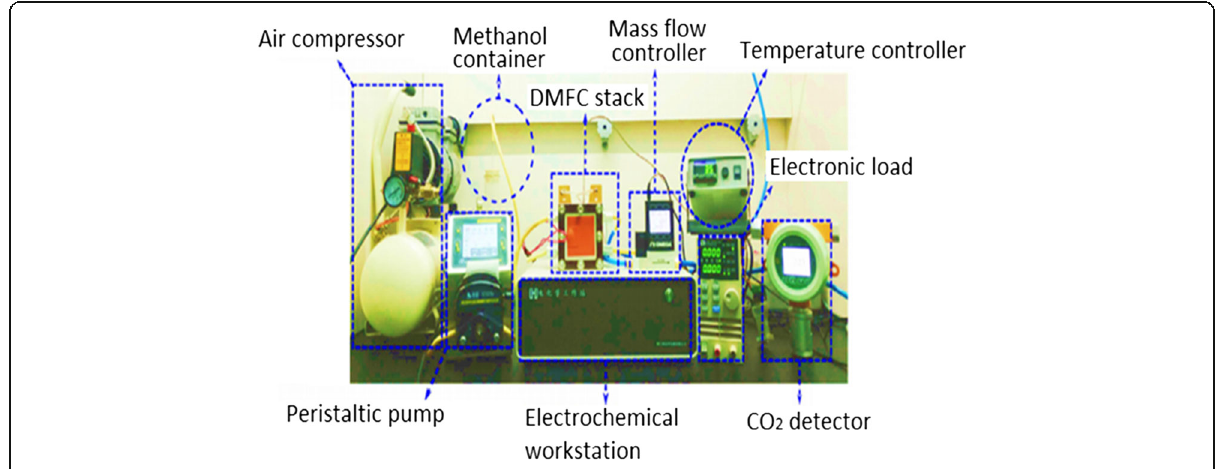
Fig. 1 A general experimental set-up for single cell DMFC